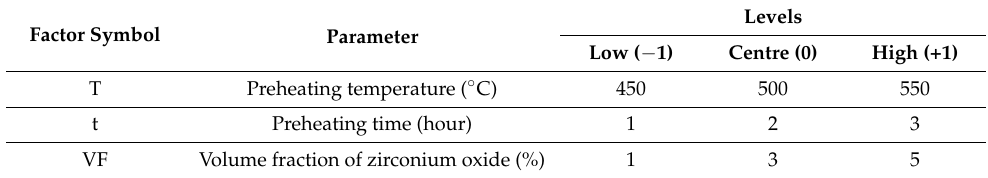
Table 4. The design scheme of the process parameters.